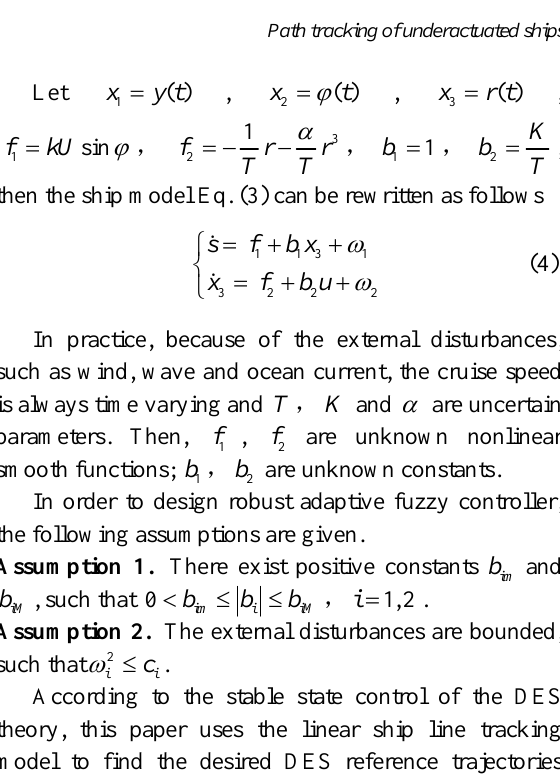
Fig. 2. Ship motion coordinate system